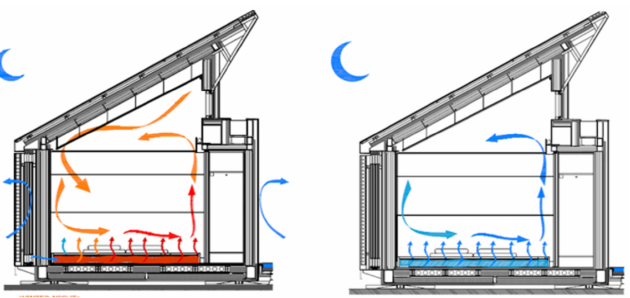
Figure 5. ( Left ): Winter night heating of phase change gel in the floor. ( Right ): Summer night cooling. Adapted from ref.